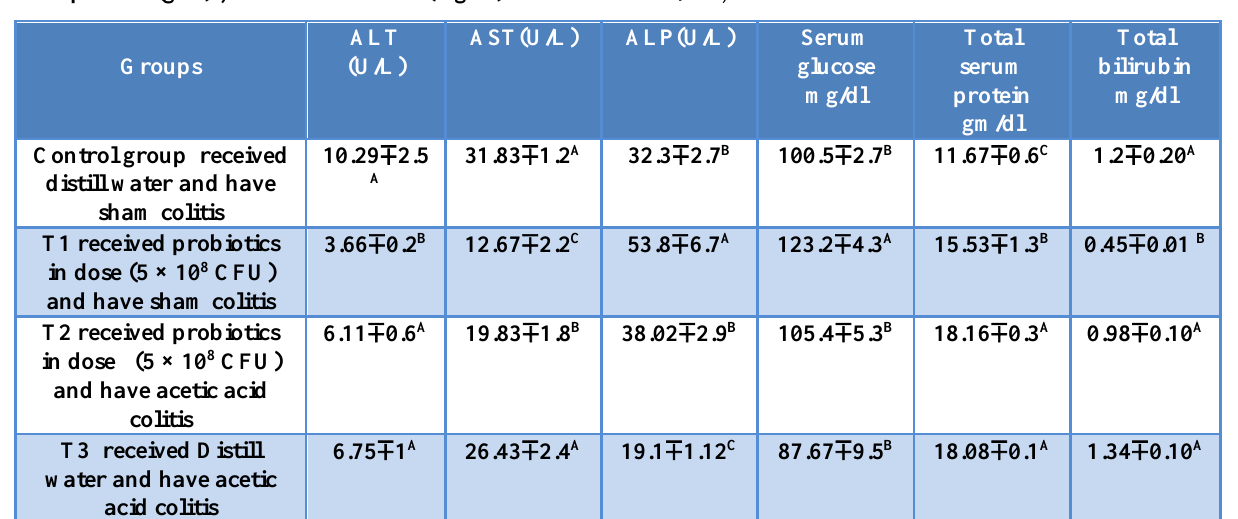
Table-1: The ameliorative effects of probiotic on Serum ALT (U/L) ,AST (U/L) , ALP (U/L), glucose(mg/dl), total protein (g/dl) , and total bilirubin(mg/dl) in Rats. Means ∓ SE, n=6